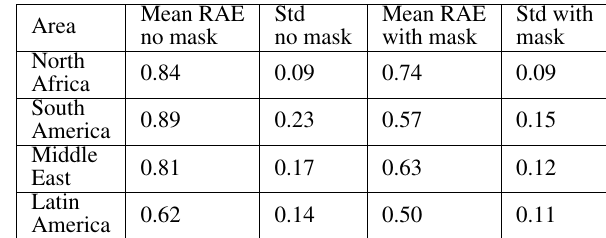
Table 1. Relative approximation error (in percentage) computed for several locations. The Mean RAE column gives the mean RAE calculated on several images of each area. The Std column gives the standard deviation of the relative error of approximation calculated on these same images.